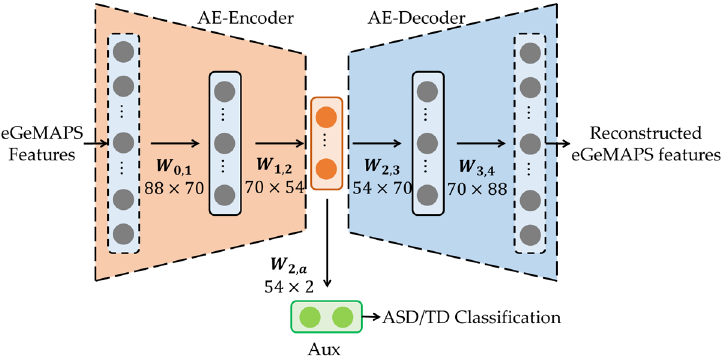
Figure 1. Network architecture for extracting bottleneck features using autoencoder with multi-task learning strategy.